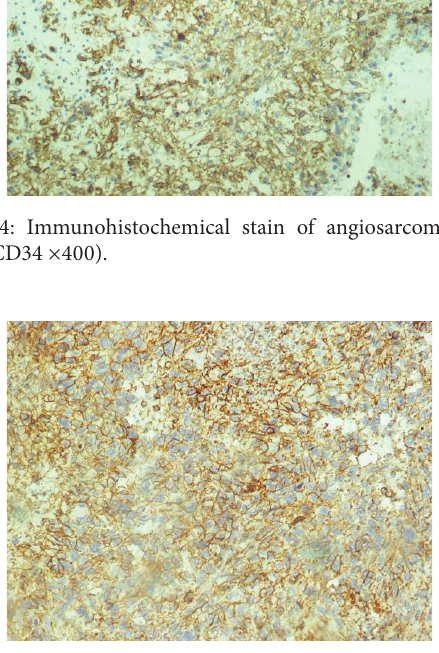
Figure 5: Immunohistochemical stain of angiosarcoma of the spleen (factor VIII ×